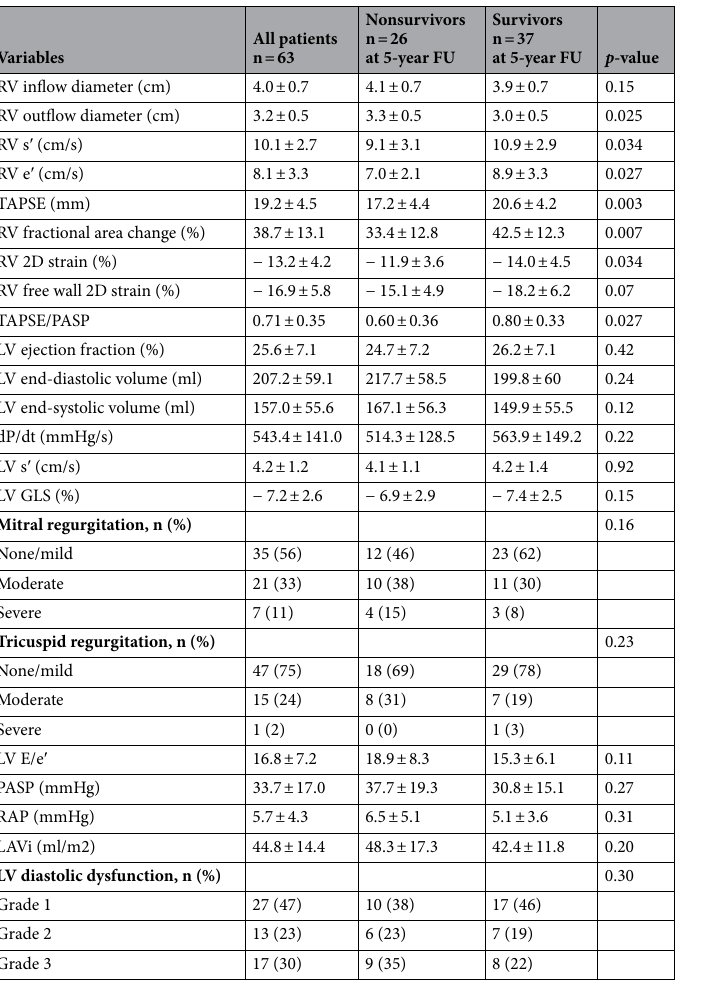
Table 2. Comparison of cardiac structure and function described by baseline echocardiographic measurements in the whole group, nonsurvivor group and survivor group. Values are expressed as the mean ± SD or counts and percent. RV, right ventricular; s ʹ , systolic myocardial velocity; e ʹ , early diastolic myocardial velocity; TAPSE, tricuspid annular plane systolic excursion; PASP, systolic pulmonary artery pressure; LV, left ventricular; GLS, global longitudinal strain; E/e ʹ , ratio of early diastolic transmitral velocity to peak early diastolic myocardial velocity; PASP, systolic pulmonary artery pressure; RAP, right atrial pressure; LAVi, left atrial volume index. LV diastolic dysfunction assessment was performed for patients in sinus